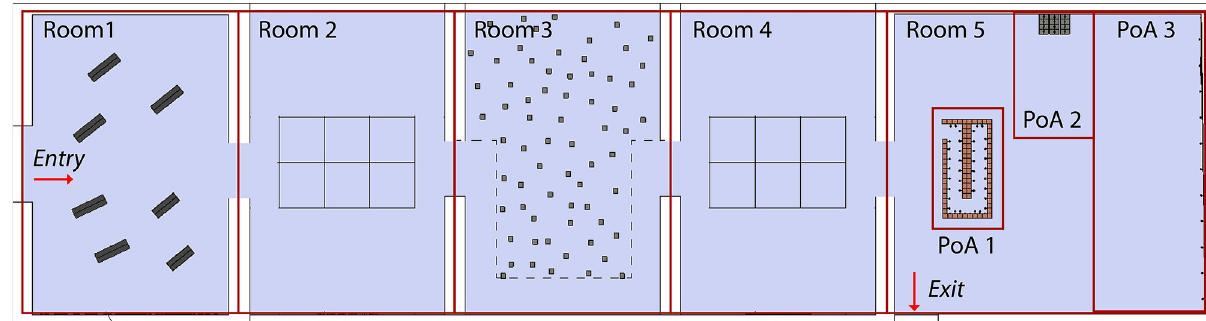
Fig 1. Plan of the art-exhibition with the 5 rooms and 3 pieces of